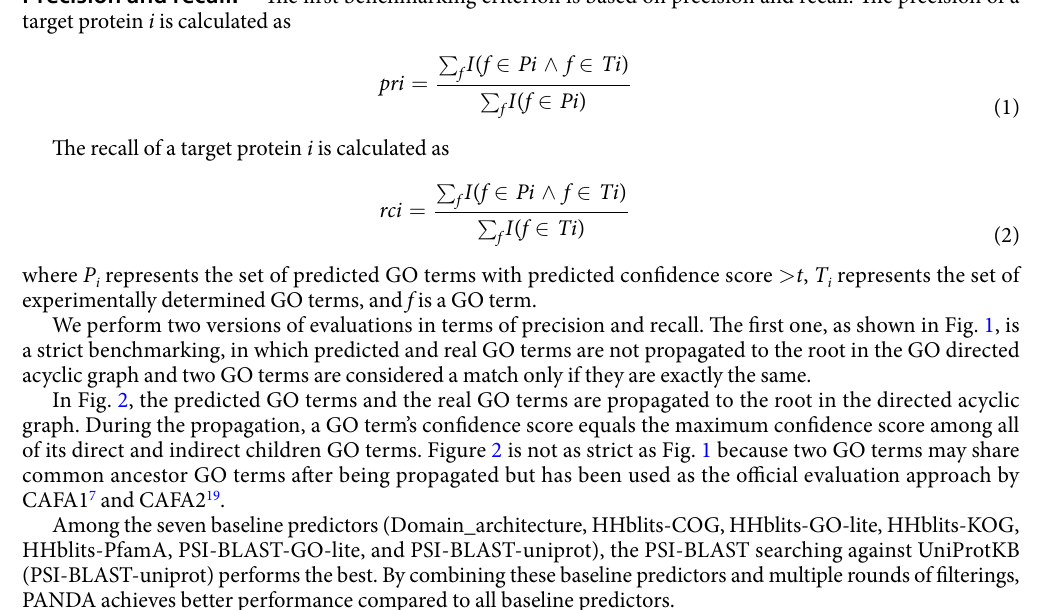
(GO terms) of each